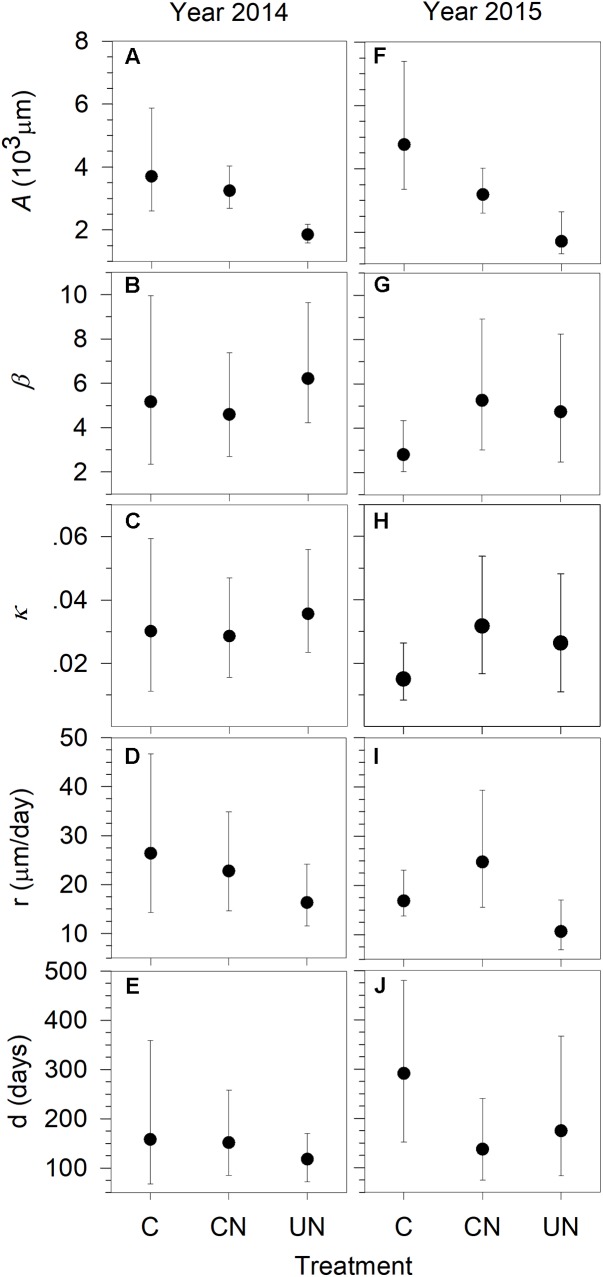
Parameters A
(A,F), β
(B,G), κ
(C,H), of the Gompertz functions fitting xylem production and r (growth rate) (D,I) and d (duration) (E,J) of sweetgum under control-C, canopy N addition-CN and understory N addition-UN treatments during 2014–2015 in Central China. The vertical bars represent 2.5 and 97.5% confidence intervals of the distributions calculated by 10,000 bootstrapped replications. Significant differences between groups were considered at p < 0.05 when the confidence intervals from two distributions did not overlap.